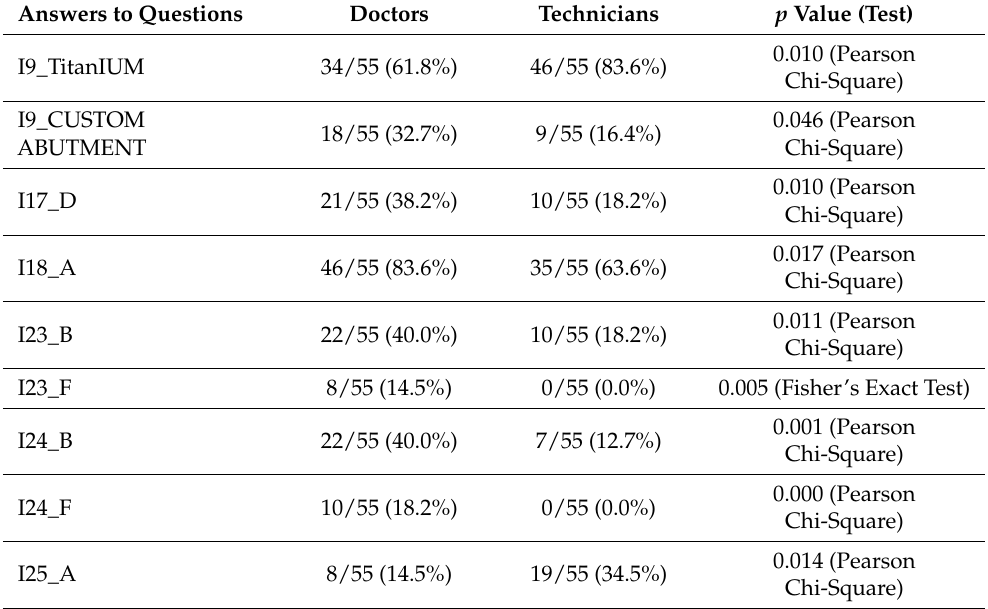
Table 6. Correlation between the answers to pairs of the questions from the two questionnaires